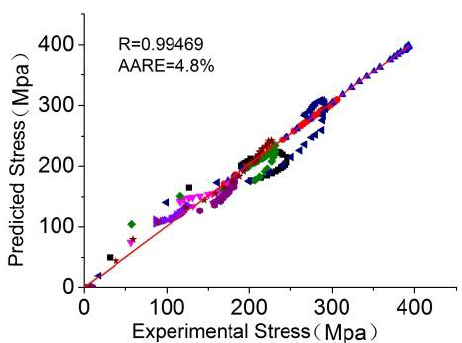
Figure 11. Flow stress relativity of the predicted and experimental values. Reproduced with permission from [24]. Copyright Elsevier, 2017.